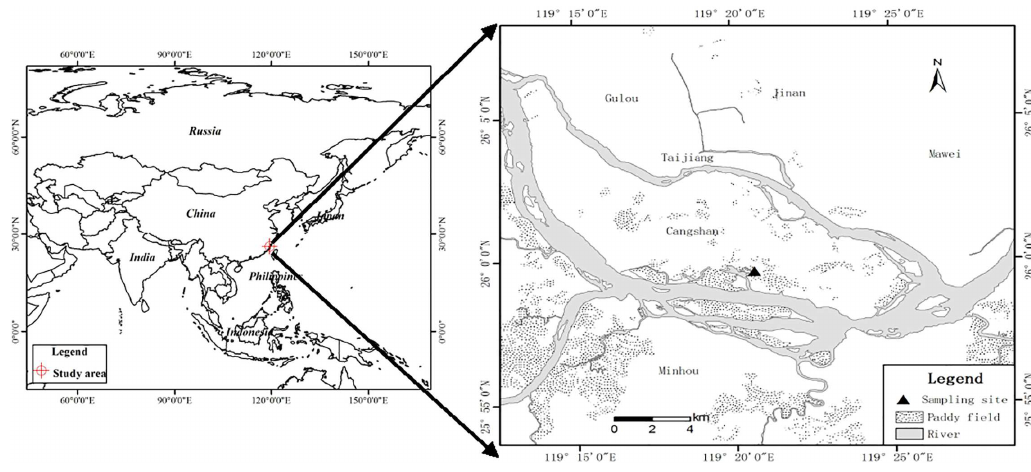
Fig 1. Location of the study area and sampling site ( ▲ ) in southeastern